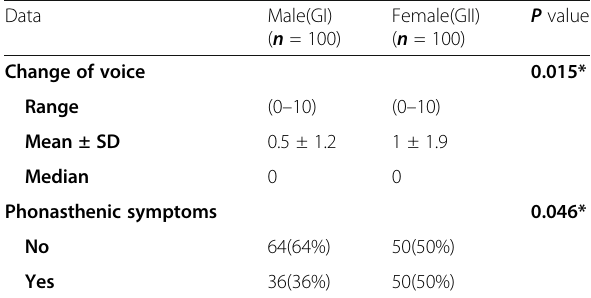
Table 4 Comparison between male and female teachers